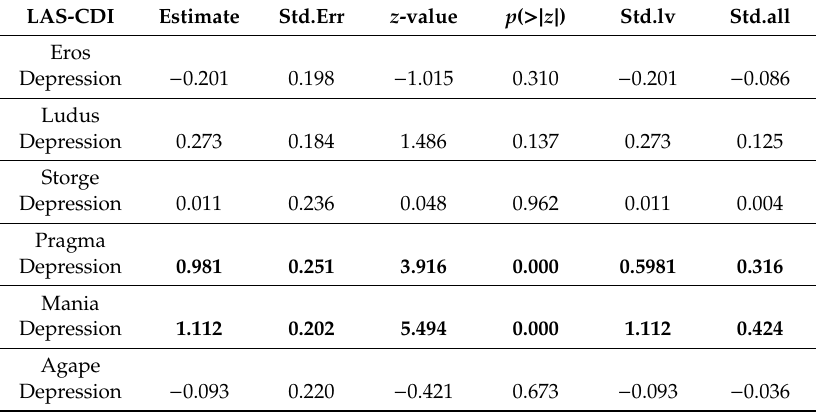
Table 2. Regression analyses of the LAS on the CDI as predictors in